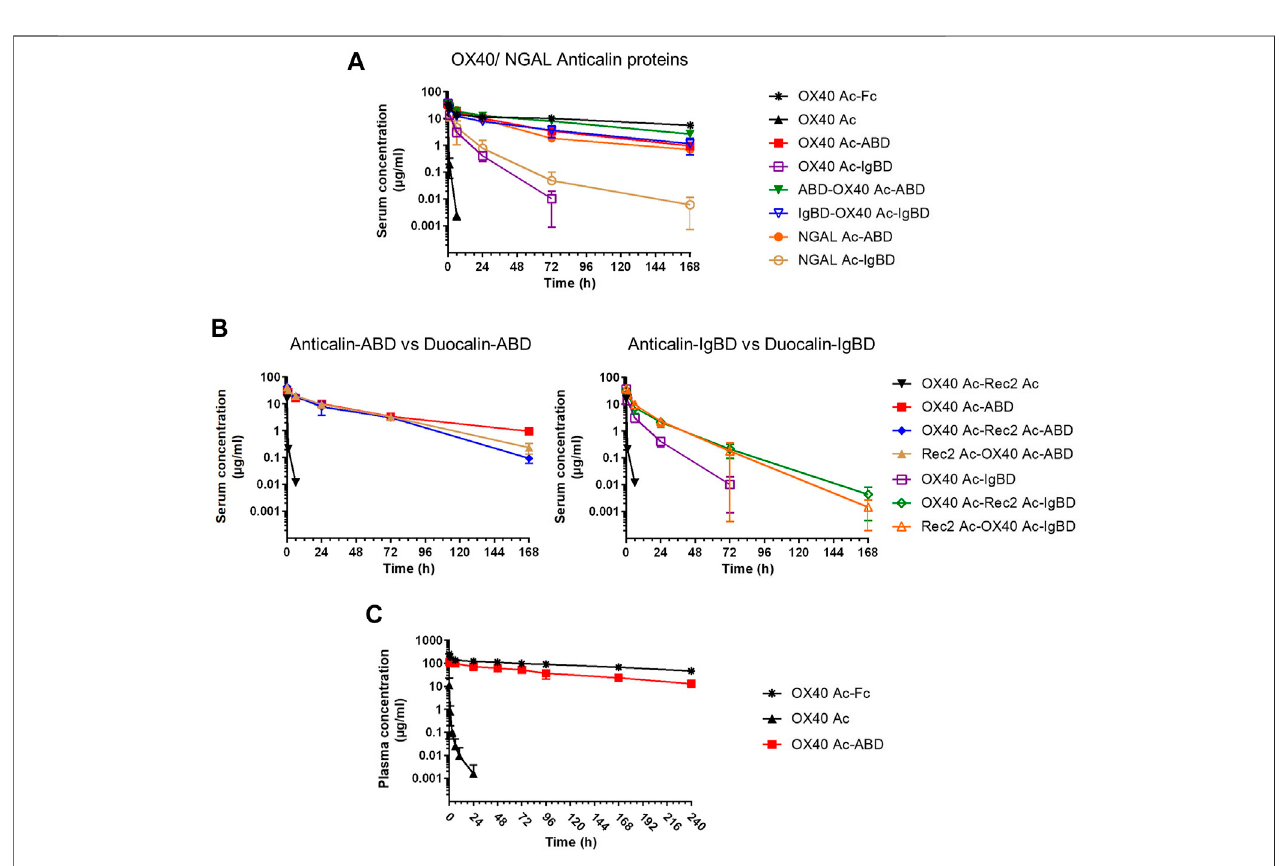
FIGURE 5 | Pharmacokinetics of Anticalin proteins in mice. (A, B) The serum concentrations after i.v. administration of 1.2 – 2.0 mg per kg bodyweight of Anticalin or Duocalin proteins with or without HLE module in CD-1 mice were analyzed by ELISA (n (cid:2) 3, mean ± S.D.). (A) Comparison of serum concentrations over time for OX40 or NGAL Anticalin proteins. (B) The serum concentrations of corresponding Duocalin proteins were plotted against the PK of OX40 Ac-ABD (left) or OX40 Ac-IgBD (right) . (C) The plasma concentrations after i.v. administration of 5 mg/kg Anticalin equivalent of OX40 Ac, OX40 Ac-ABD and OX40 Ac-Fc in hSA/hFcRn double humanized mice were analyzed by ECLA (n (cid:2) 3, mean ± S.D.).